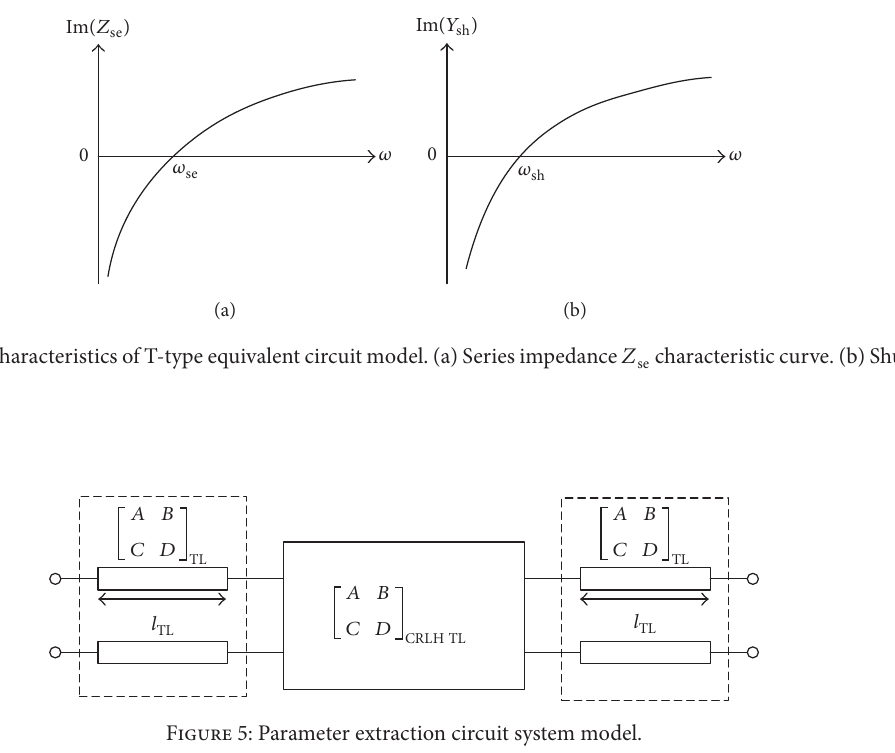
Figure 5: Parameter extraction circuit system model.